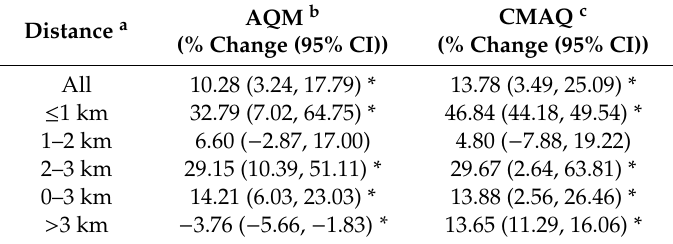
Table 3. Comparison of the effects of AQM- and CMAQ-NO 2 on atopic dermatitis symptoms according to the distance from the residences to the nearest air quality monitoring sites.